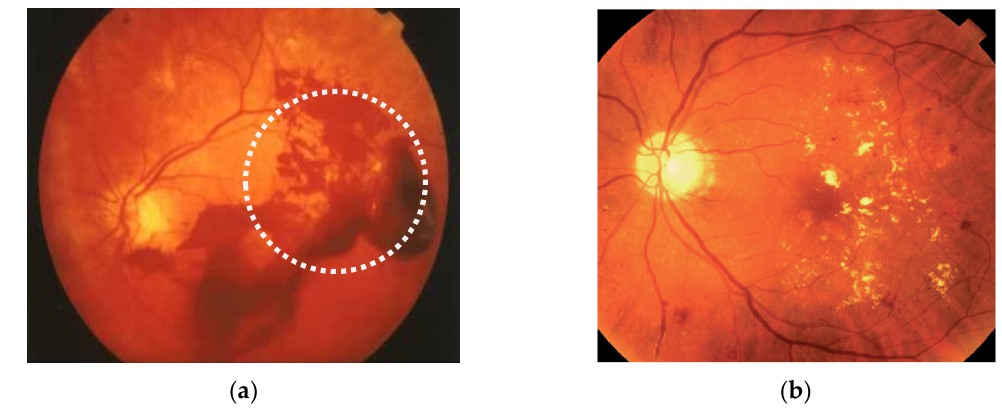
Figure 1. ( a ) Large numbers of dark floaters or cobwebs indicated the appearance of vitreous hemorrhage before treatment; ( b ) multiple symptomatic vitreous opacity gradually disappeared as perceived intraocular blood clots after 3 months of treatment.